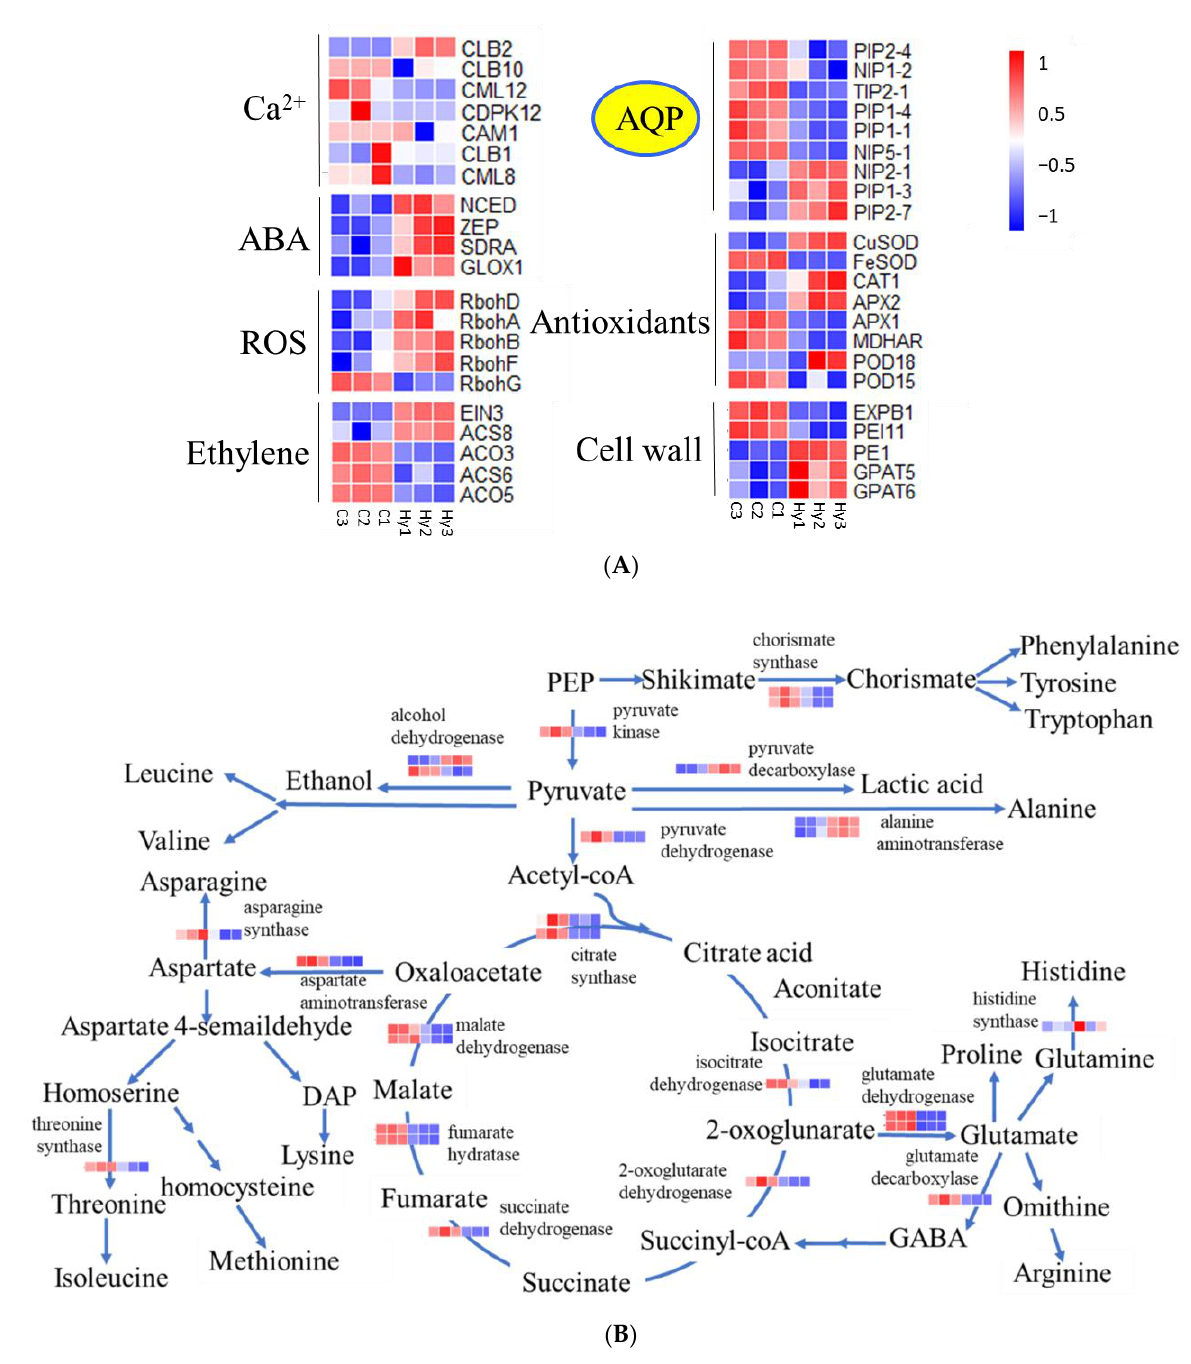
Figure 9. A model of hypoxia-response mechanisms in B. napus . ( A ) Hypoxia stress in roots is rapidly recognized through ABA, ROS, and ethylene signaling pathway. The signaling pathways stimulate a transcriptional cascade. The physiological-responsive genes are associated with a range of metabolic activities including cell wall composition adjustments, AQP alterations, antioxidants production, and TCA related enzymes. ( B ) Hypoxia-induced genes involved in respiration processes. Genes were labeled using individual heatmaps. The color bar is the scale for the expression levels of each gene on the basis of FPKM (fragments per kilobase million) value.